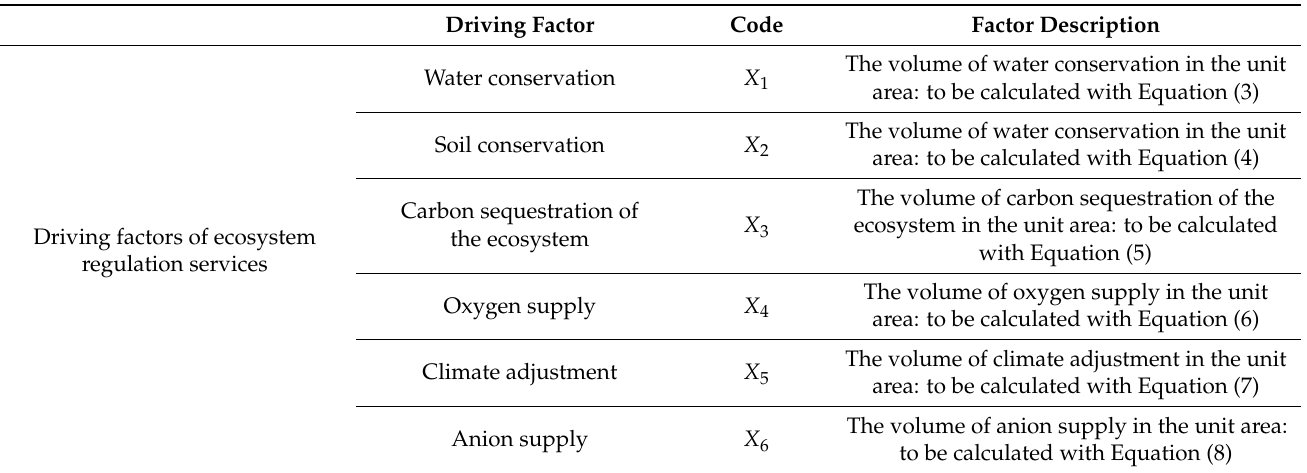
Table 3. Classification of driving factors of rural tourism spatial distribution.